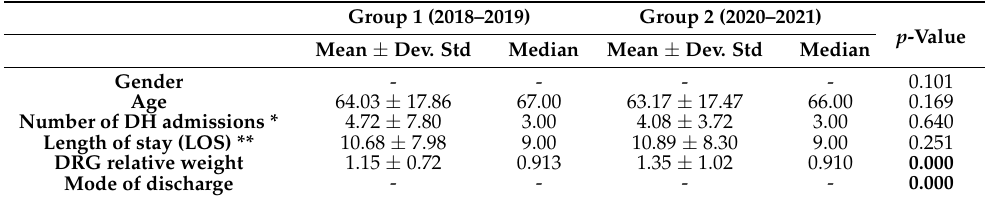
Table 7. Statistical